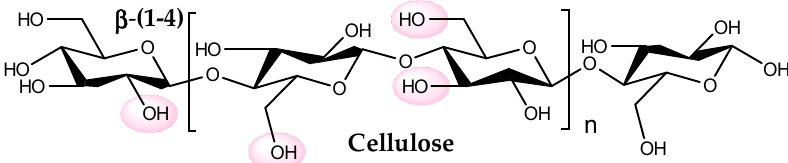
Figure 11. Schematic representation of cellulose structure. The backbone is a linear homopolymer of β -(1–4)-linked D -glucose residues. The light pink circles randomly highlight the hydroxyl groups that can be chemically modified.